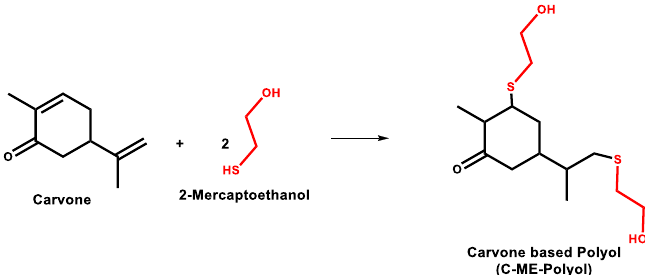
Figure 1. The chemical reaction for the synthesis of carvone-based